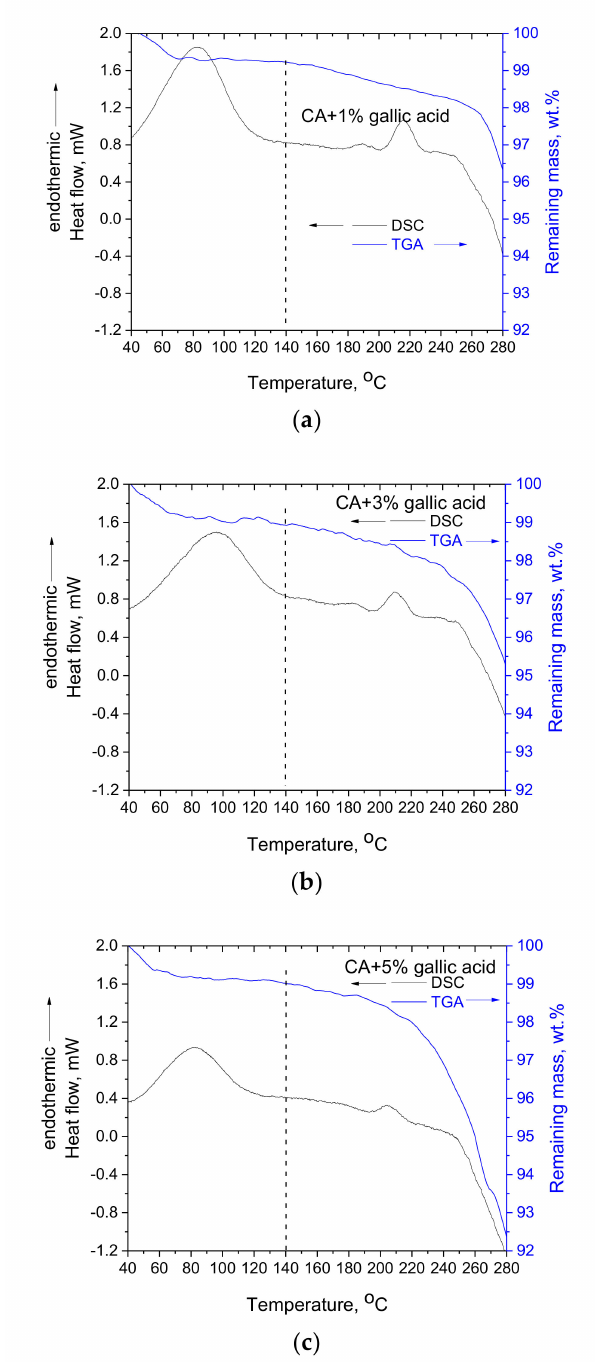
Figure 5. DSC and TGA curves of CA-gallic acid composite membranes with gallic acid loadings of 1 wt.% ( a ), 3 wt.% ( b ) and 5 wt.% ( c